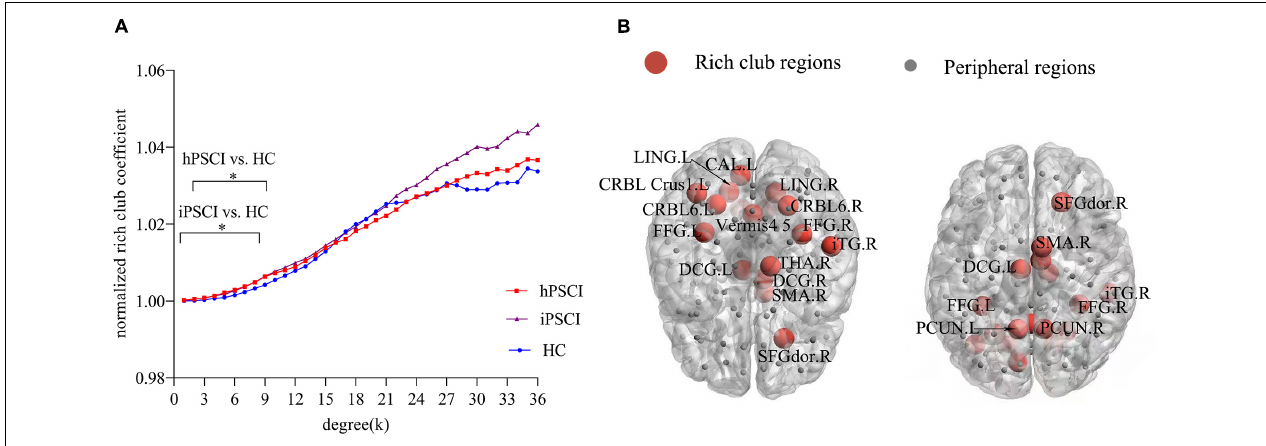
FIGURE 1 | Rich club organization. (A) Normalized rich club coefficients at k value ranging from 1 to 36. *The differences were seen in hPSCI ( k = 2-8) and iPSCI ( k = 1-8) versus HC ( p < 0.05). (B) The number of rich club regions (red nodes) in all participants. HC, healthy controls; hPSCI, hemorrhagic post-stroke cognitive impairment; iPSCI, infarct post-stroke cognitive